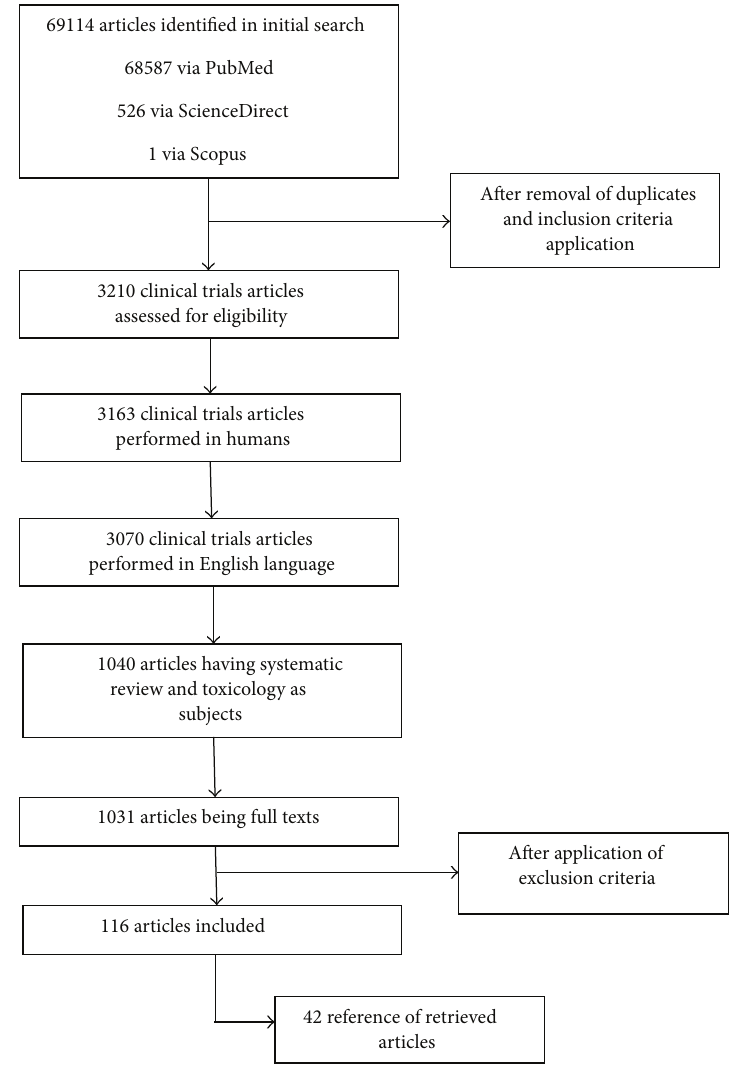
Figure 1: Flow of papers identified from search